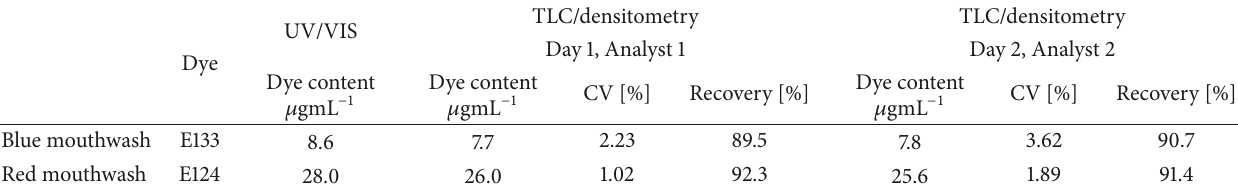
Table 5: Dye concentrations in real samples determined by UV/VIS spectrophotometry or SPE followed by